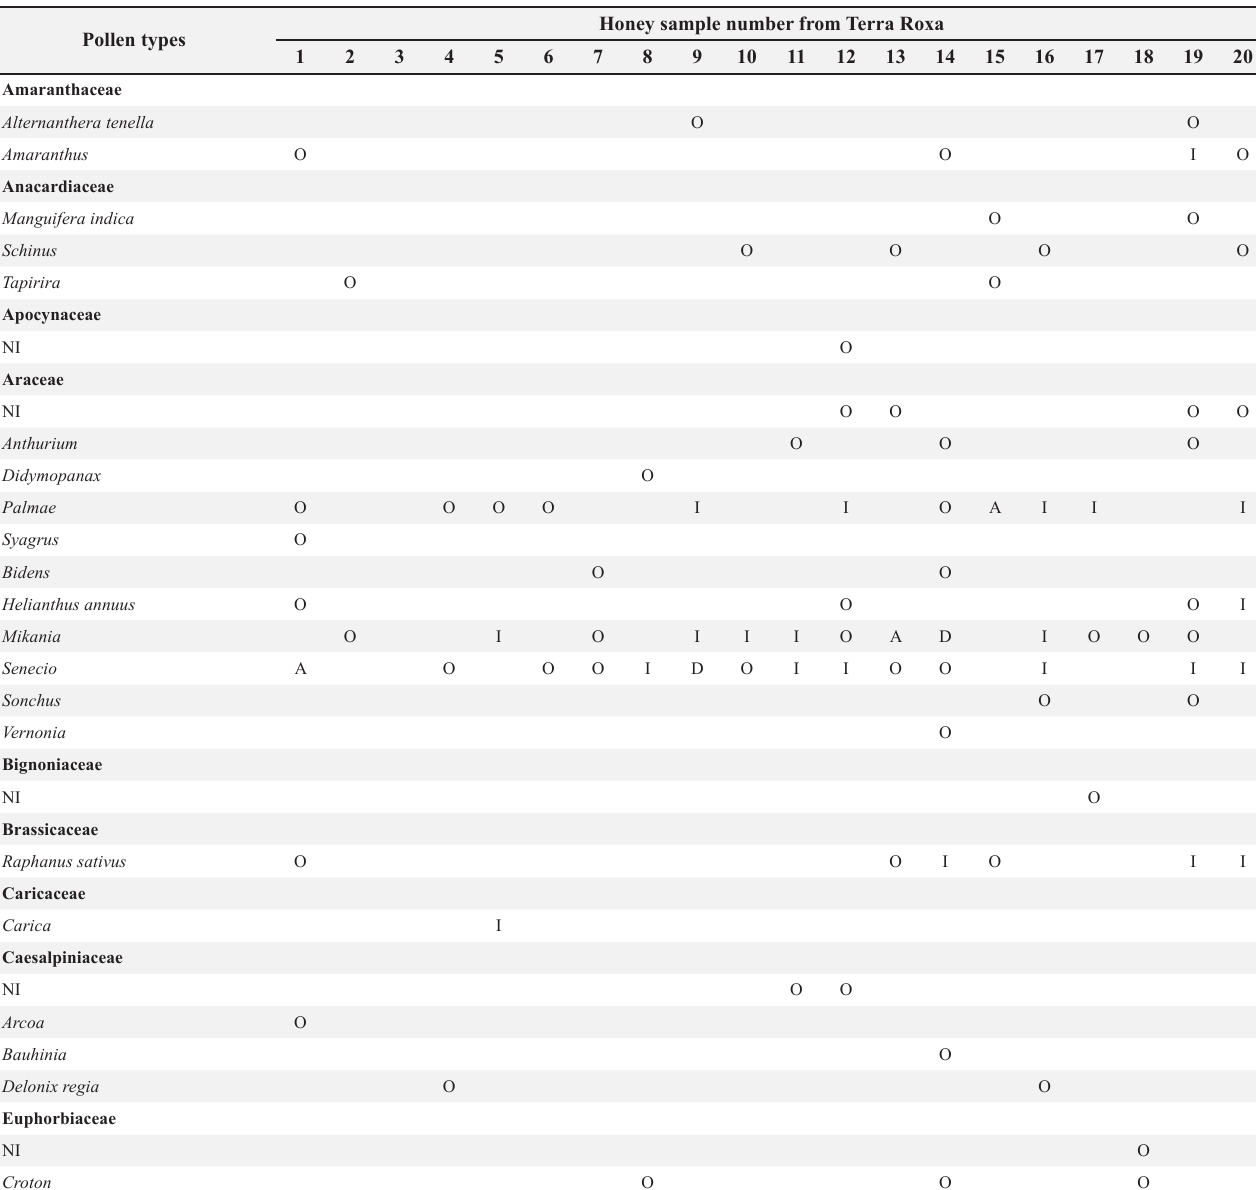
Table 2. Pollen types and frequency classes of: Terra Roxa honey sampless, where: D: dominant pollen (> 45%); A: accessory pollen